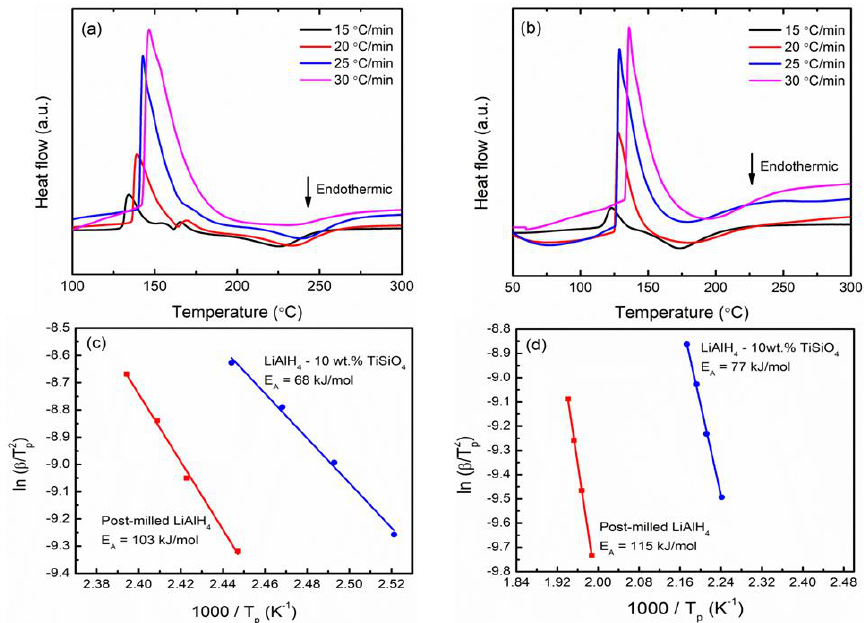
Figure 3. DSC dehydrogenation curves at different heating rates for ( a ) post-milled LiAlH 4 , ( b ) LiAlH 4 – 10 wt% TiSiO 4 and Kissinger’s plot for the ( c ) first and ( d ) second dehydrogenation stage of post-milled LiAlH 4 and LiAlH 4 added with 10 wt% TiSiO 4 .